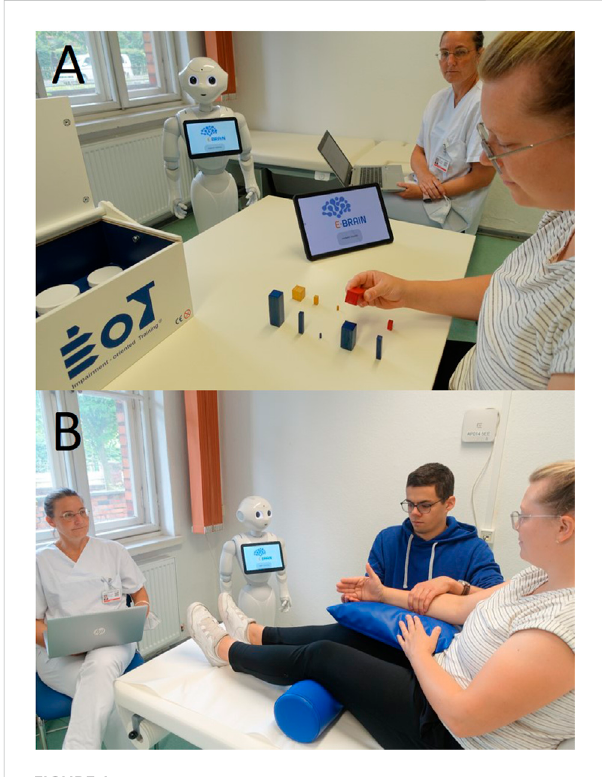
Trainingsetup. (A) AATforstrokepatientswithmildarmparesis,a scenario with the patient, humanoid robot, and supervising staff. (B) ABTforpatientswithmoderate-to-severearmparesis,ascenariowith